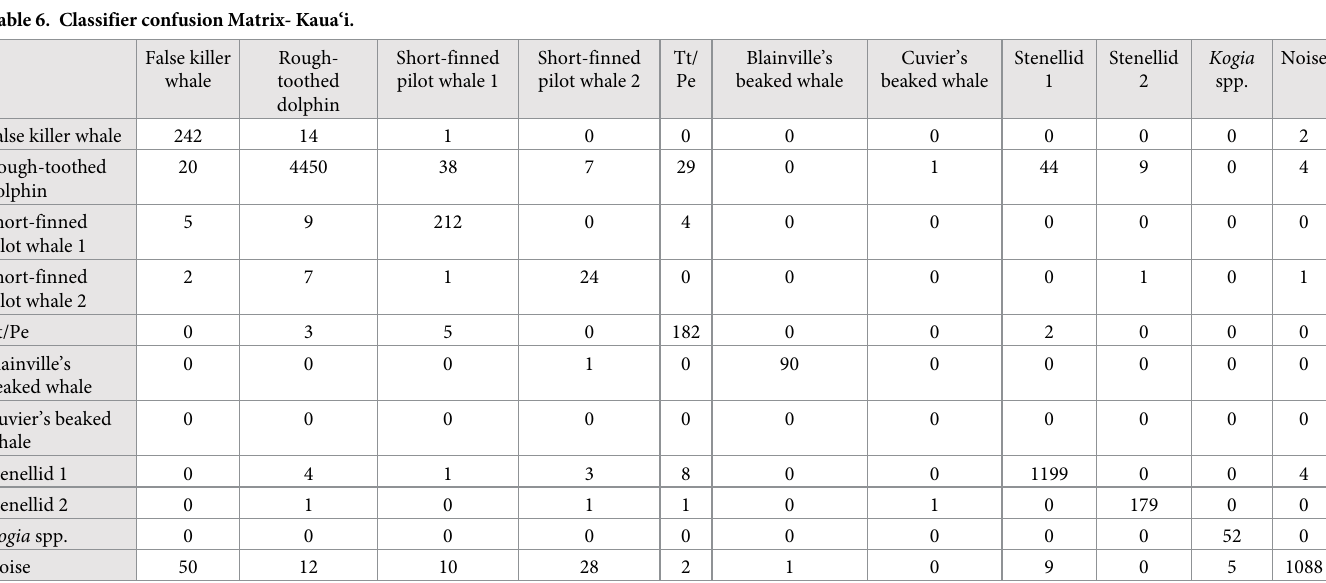
Table 6. Classifier confusion Matrix-